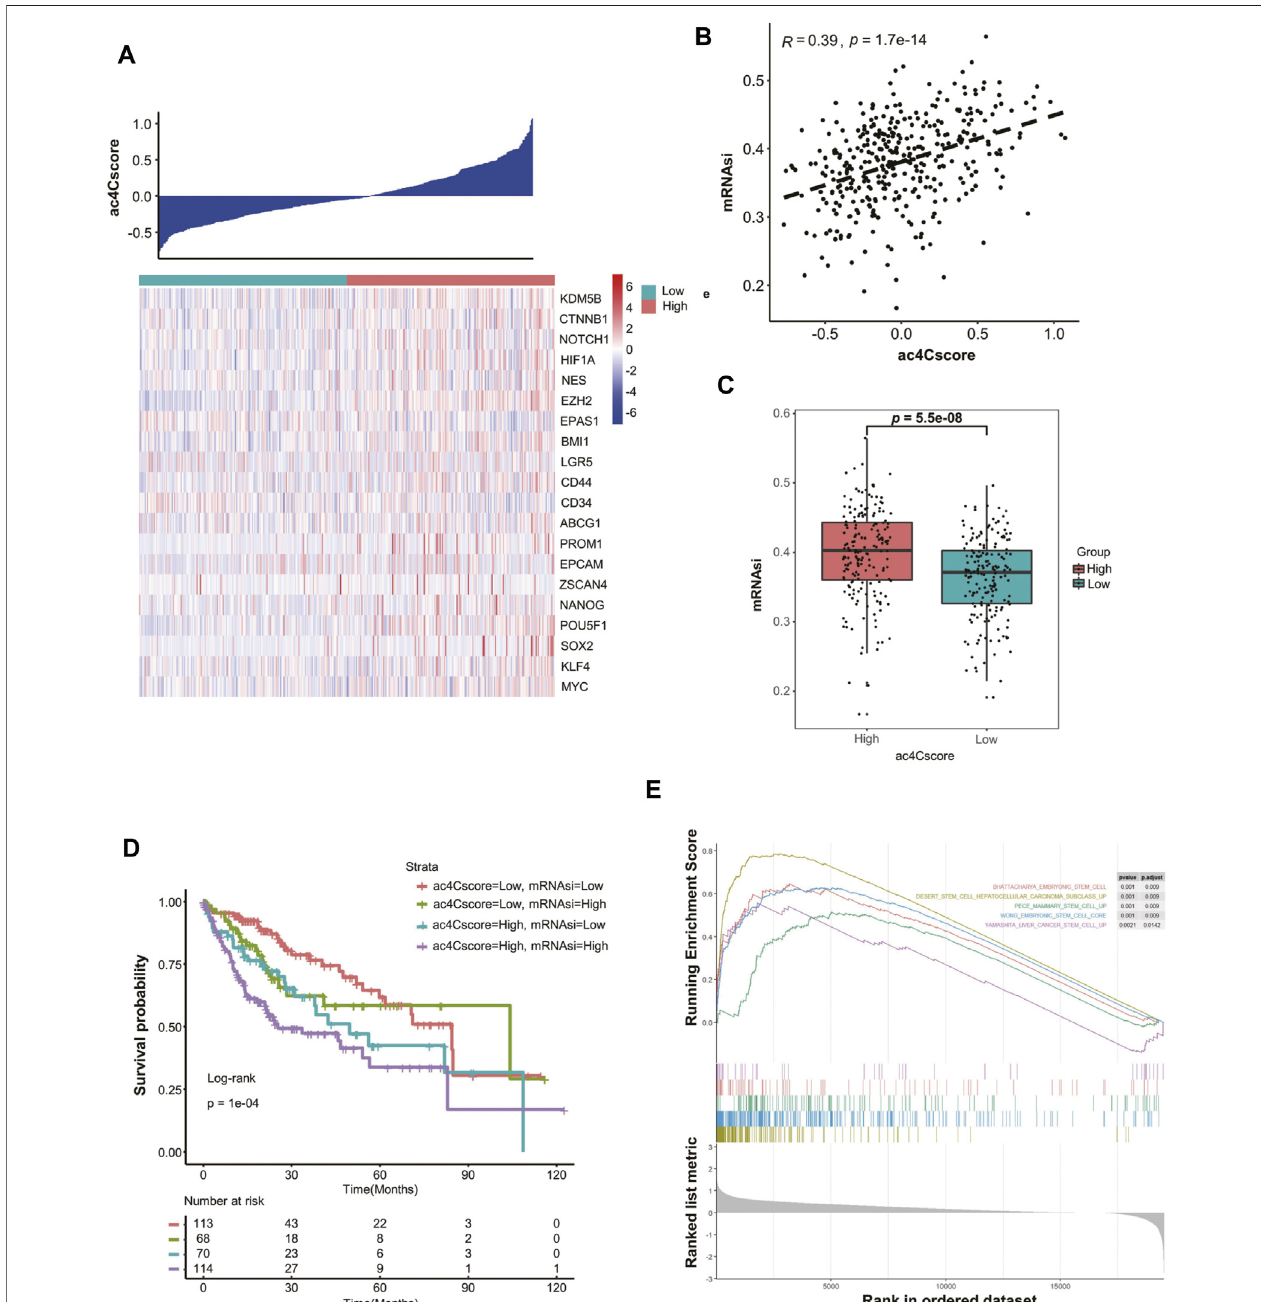
FIGURE 4 | ac4Cscore is associated with tumor stemness. (A) Heatmap delineates the relationship between ac4Cscore and stem cell markers. (B) Correlation of ac4Cscore and estimated mRNAsi. A Pearson correlation coef fi cient with p value < 0.05 is considered signi fi cant. (C) The mRNAsi values between the ac4Cscore high and low groups. Each dot represents the value of individual patient. T test with p value < 0.05 is considered signi fi cant. (D) Survival analysis based on ac4Cscore and mRNAsiofpatients.Log-rankttestwith p value < 0.05isconsideredsigni fi cant. (E) GSEAplotsshowtheupregulatedgenesintheac4Cscorehighgroupenriched in several stemness-related gene sets. Strict criterion with p value < 0.01 and adjusted p value < 0.05 is considered signi fi cant.